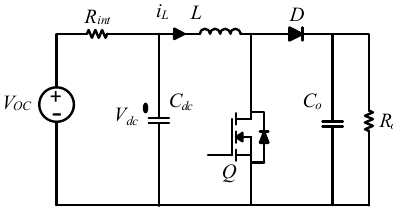
Figure 2. TEG model connected with boost converter.